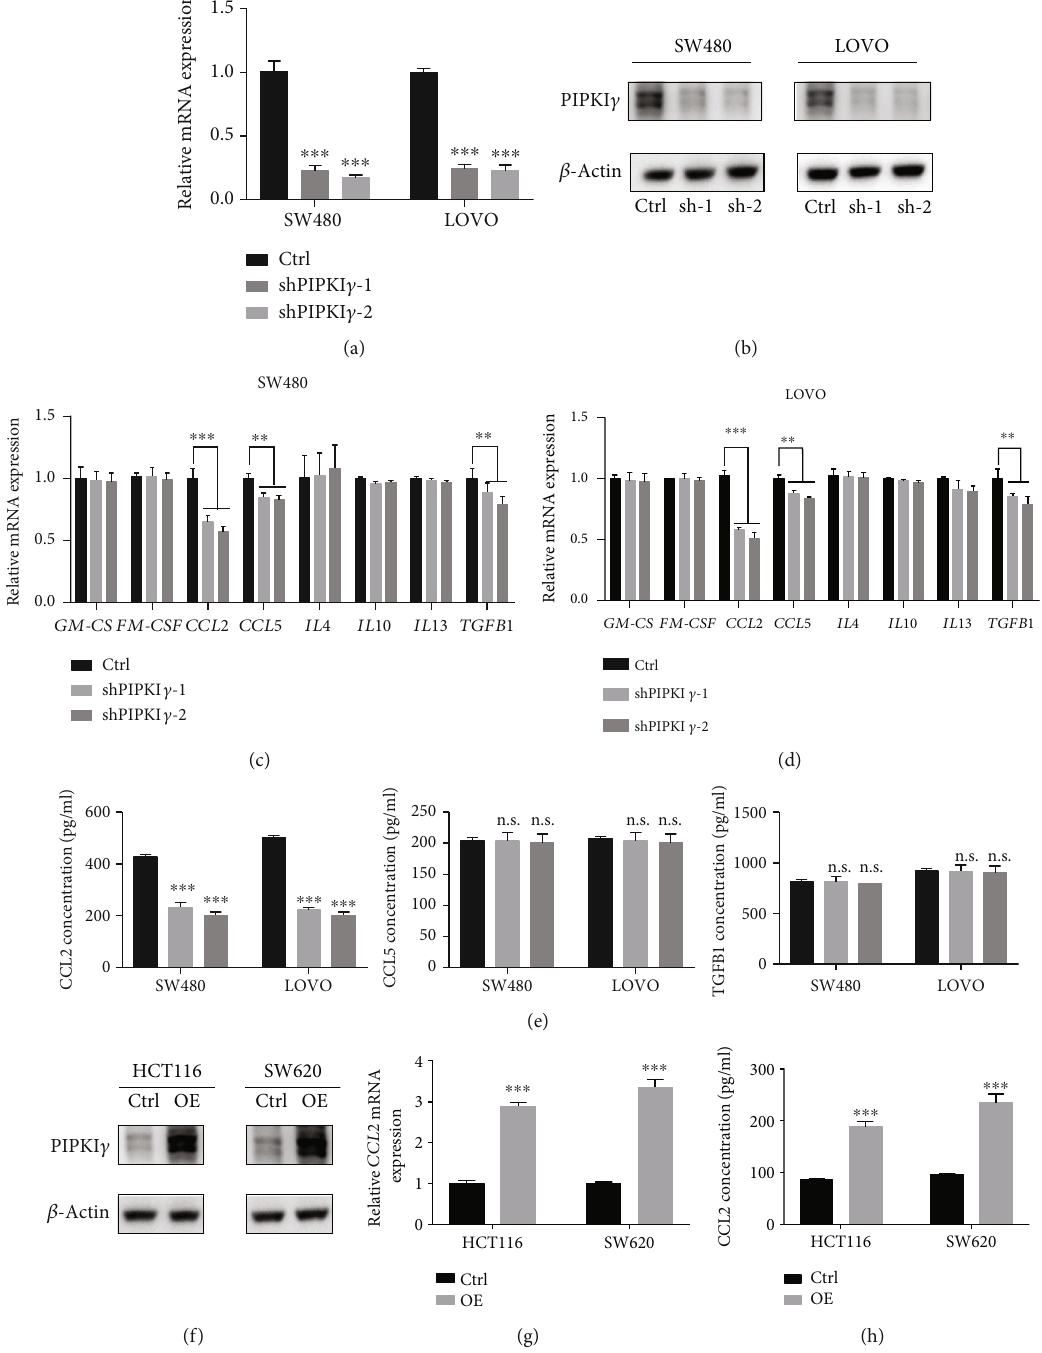
Figure 2: Upregulated PIP5I γ increased CCL2 expression in CRC cancer cells. (a) Stable shPIP5K1C-expressing SW480 and LOVO cells were grown in normal medium for 48 h, and PIP5K1C mRNA levels were measured by quantitative PCR with reverse transcription (RT-qPCR) ( n = 3 , data are the mean + SD ) (b) Western blot analysis of the e ff ect of PIPKI γ knockdown in SW480 and LOVO cells. Experiments were repeated twice, and representative results are presented. (c, d) Stable shPIP5K1C-expressing SW480 and LOVO cells were grown in normal medium for 48h, and GM-CSF, M-CSF, CCL2, CCL5, IL4, IL10, IL13, and TGFB1 mRNA levels were measured by quantitative PCR with reverse transcription (RT-qPCR) ( n = 3 , data are the mean + SD ). (e) Stable shPIP5K1C-expressing SW480 and LOVO cells were grown in FBS-free medium for 48 h, and ELISAs were performed to determine CCL2, CCL5, and TGFB1 levels in the CM from sh- Ctrl and sh-PIP5K1C SW480 and LOVO cells ( n = 3 , data are the mean + SD ). (f) Western blot analysis of the e ff ect of PIPKI γ overexpression in HCT116 and SW620 cells. Experiments were repeated twice, and representative results are presented. (g) q-PCR analysis of the mRNA level of CCL2 in PIPKI γ -overexpressing HCT116 and SW620 cells. (h) ELISA was performed to determine the protein level of CCL2 in PIPKI γ -overexpressing HCT116 and SW620 cells cultured in FBS-free